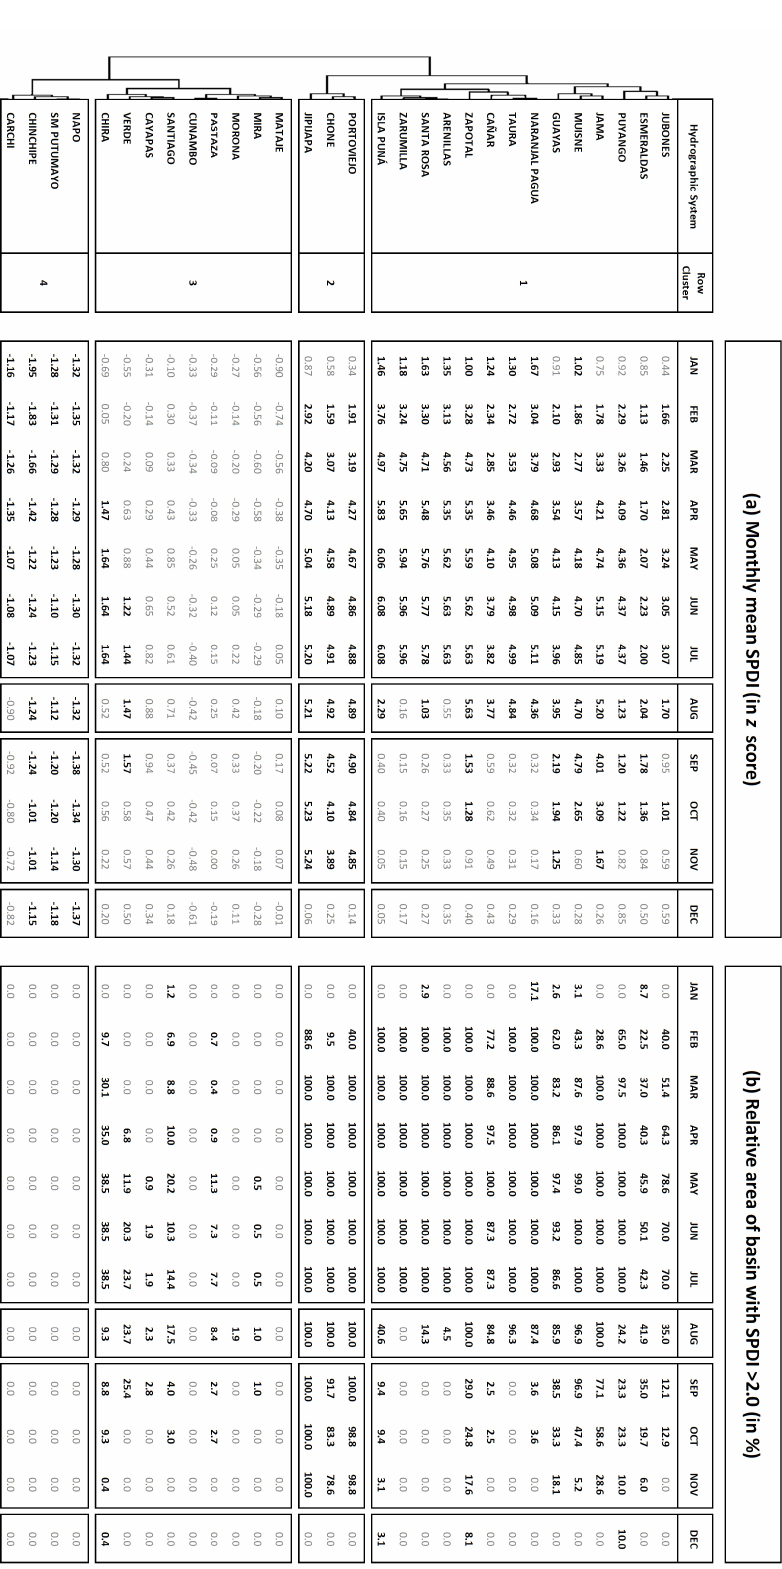
Table 3. Standardized Precipitation Drought Index (SPDI) temporal and spatial dynamics at the different hydrographic systems for 1998 (Year 2) of the mega-El Niño event EP98. Cluster analysis ( K -means clustering using Euclidean distance) was performed on both rows and columns and with the statistical tool ClustVis (Metsalu and Vilo,